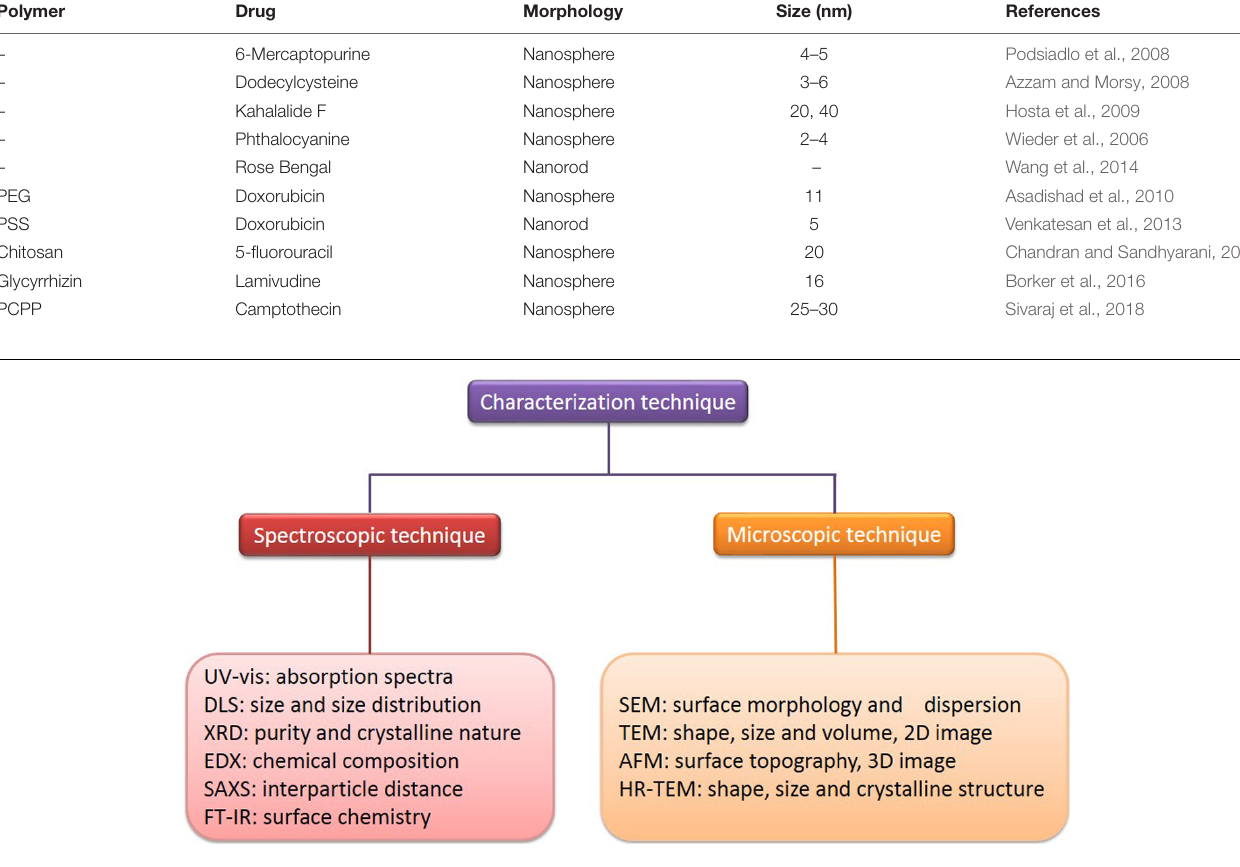
TABLE 3 | Functionalized AuNPs without/with polymer for drug delivery with different morphology and size. Polymer